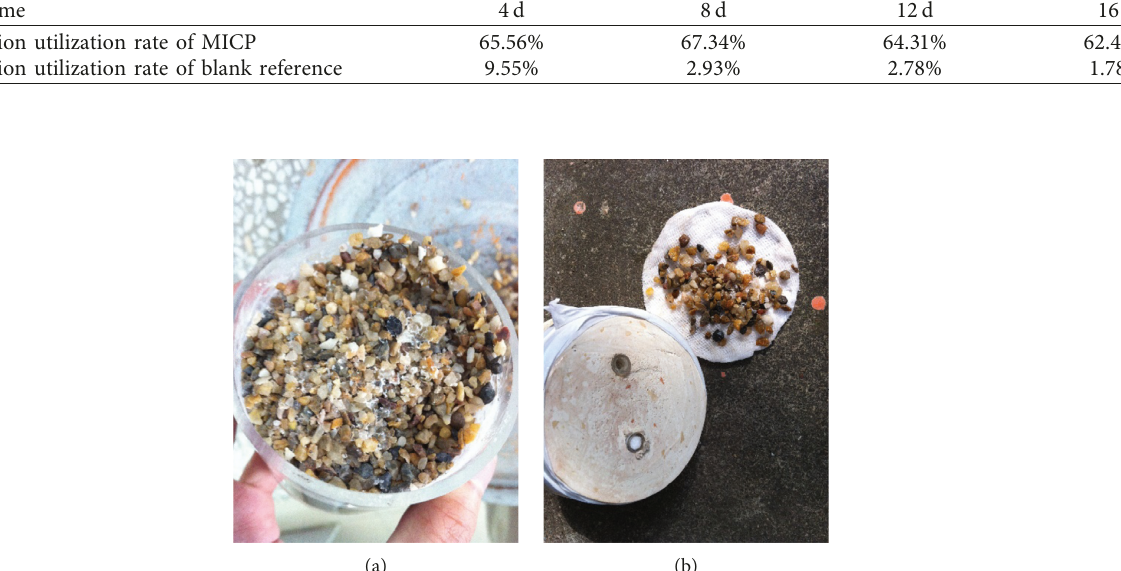
Figure 13: Deposition of CaCO 3 in gravel layers and gauze layers: (a) buffer gravel layer; (b) grouting mouth and gauze